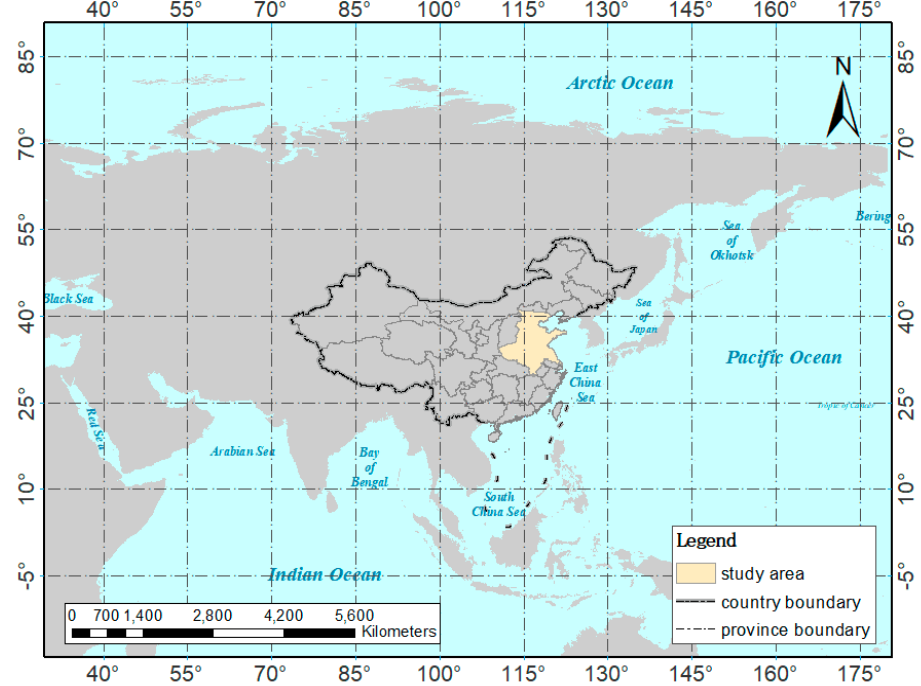
Figure 1. Location of the study area.